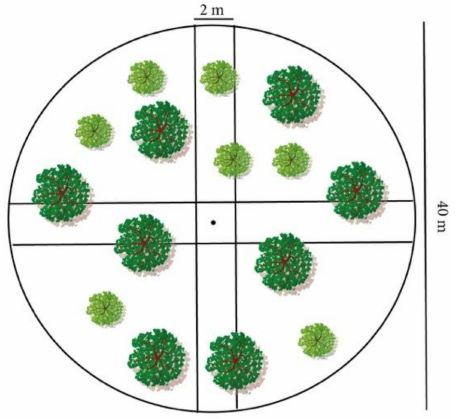
Figure 2. Simplified scheme of a sampling plot: a circular area of 40 m diameter with two perpendic- ular